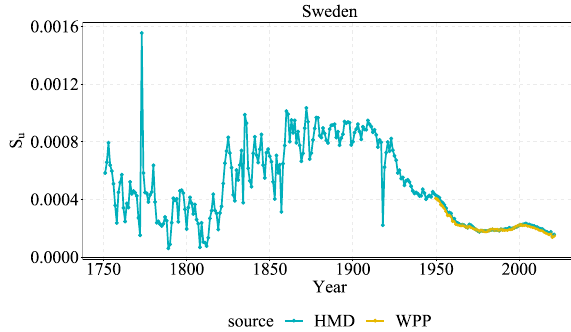
Fig. 12 S u value in Sweden from HMD and WPP, 1751–2021